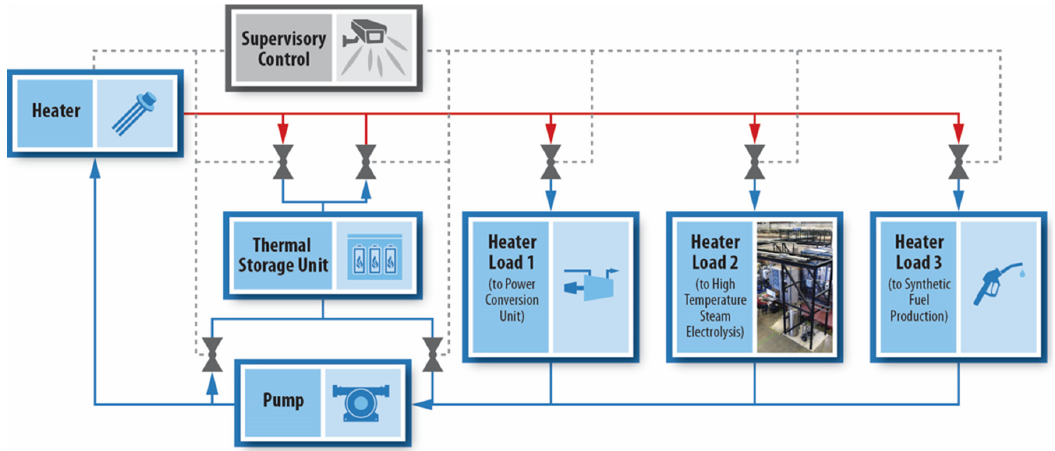
Figure 2. Thermal Energy Distribution System (TEDS) schematic diagram.